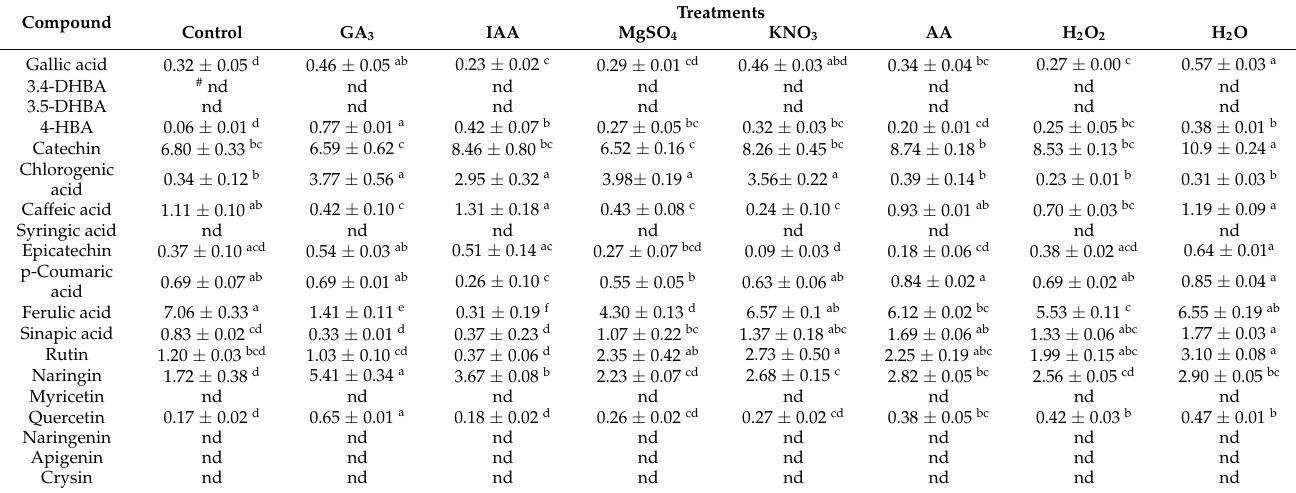
Table 5. The qualitative and quantitative composition of phenolic acids and flavonoids ( µ g of g − 1 of dry extract) of wheat seedlings after different priming